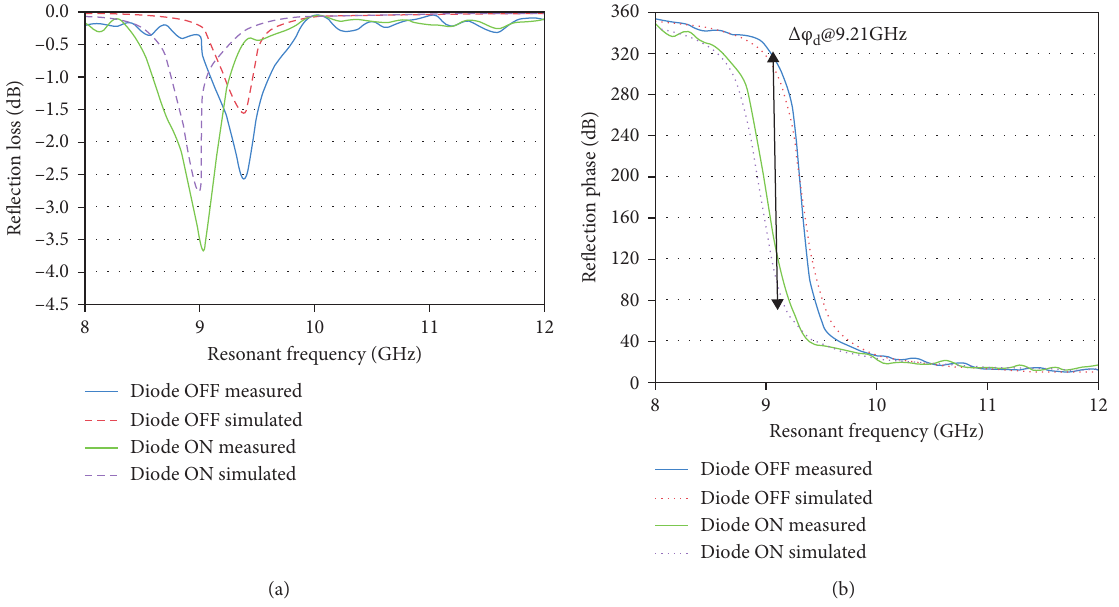
Figure 2: PIN diode-based active unit cells of reflectarrays. (a) Measured and simulated reflection loss curves. (b) Measured and simulated reflection phase